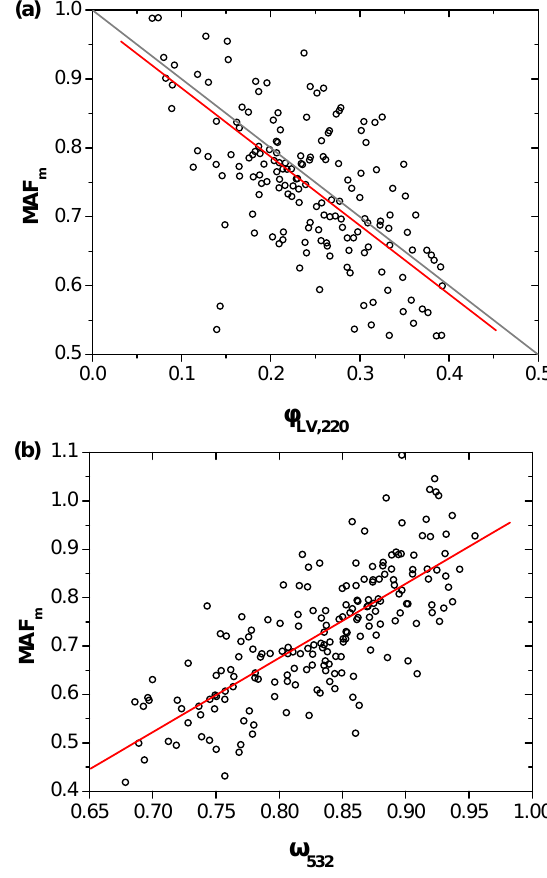
Fig. 7. Correlation between (a) the number fraction of activated par- ticles at 270nm (MAF m ) for S = 0 . 068% and the number fraction of LV-particles at 220nm ( φ LV , 220 ) and (b) MAF m for S = 0 . 068% and the single scattering albedo ( ω 532 ). The red lines are linear least squares fit lines through the data points with the following equa- tion, correlation coefficient, and number of data points: (a) y = 0 . 986 − 0 . 997 x , R 2 = 0 . 47, n = 170; and (b) y = − 0 . 55 + 1 . 53 x , R 2 = 0 . 57, n = 192. The grey line in (a) is to guide the eye. In Fig. 7a the number fraction of 270 nm particles that activate at S = 0 . 068% (MAF m ) is plotted versus the num- ber fraction of LV-particles at 220 nm as determined by the VTDMA ( φ LV , 220 ). In the CCN measurements, the 270 nm size bin was the largest size selected. For all supersatura- tions, the measured CCN efficiency spectra were not any- more raising at this size but reached a plateau level (MAF m ; cf. Fig. 3 of Rose et al., 2010a). In the VTDMA measure- ments, the 220 nm size bin is the largest size selected. It can be assumed that φ LV measured at this size is comparable to φ LV at 270 nm, as seen from comparing the LV-particle size distribution with the CN size distribution (Fig.